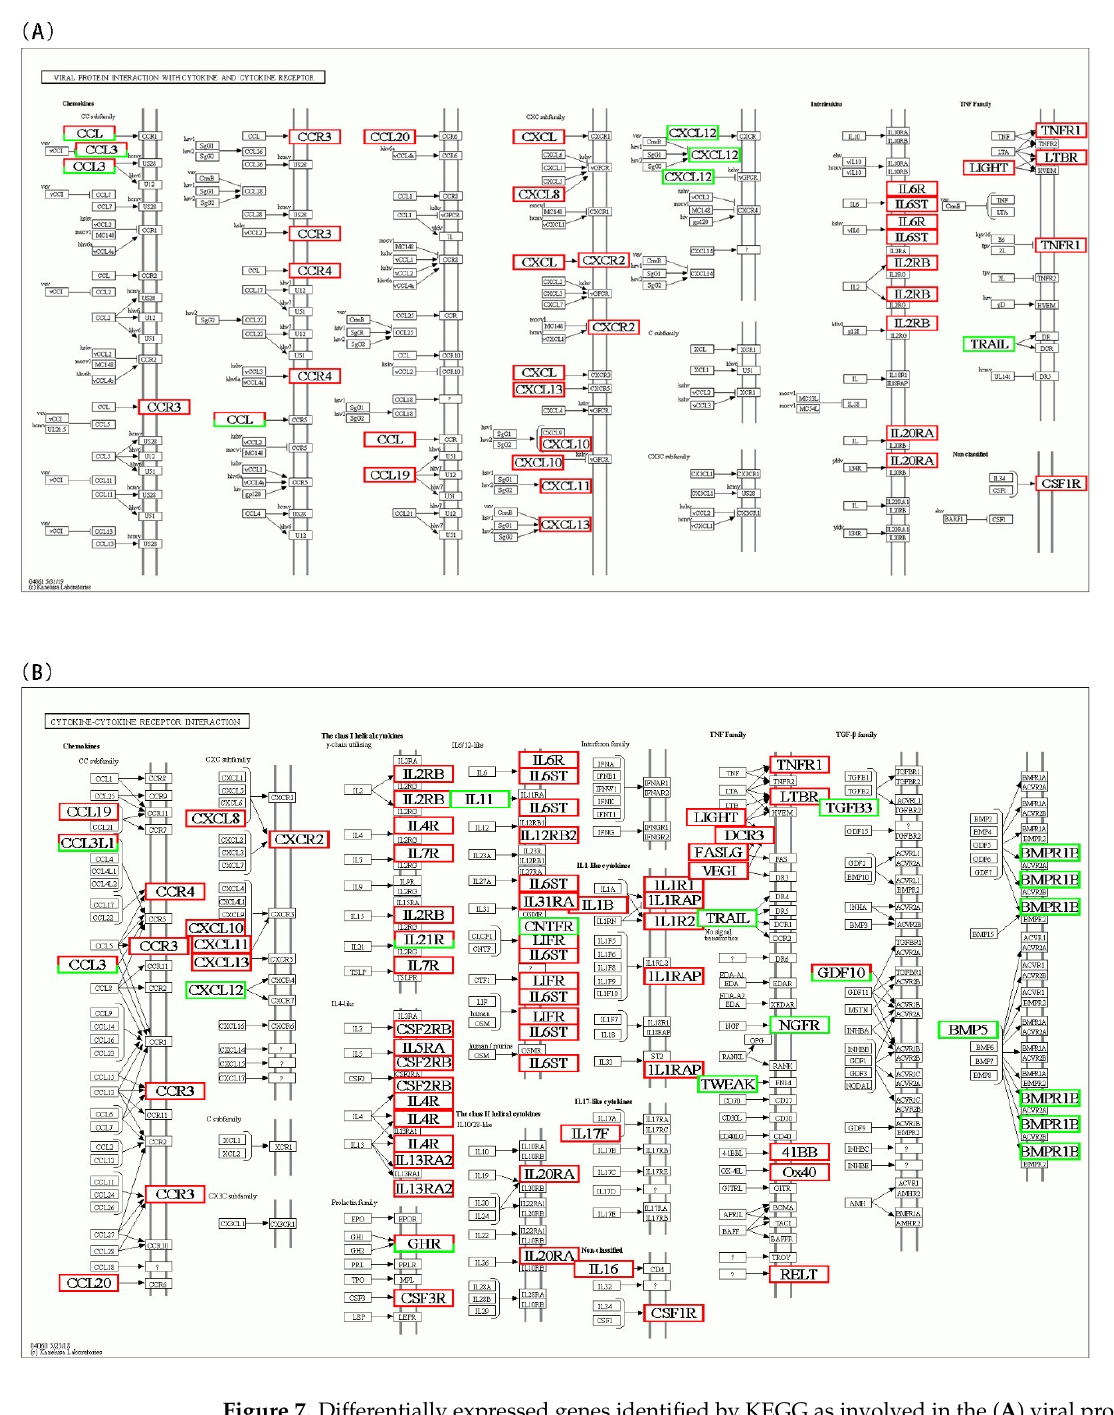
Figure 7. Differentially expressed genes identified by KEGG as involved in the ( A ) viral protein interaction with cytokine and cytokine receptor (ko04061) and ( B ) cytokine–cytokine receptor interaction (ko04060) after AO infection. The color of the boxes indicates the fold change in each gene. When a gene was increased after AO infection, it was colored red. If a gene was downregulated, it was colored green. Genes with white boxes were not detected in the analysis.